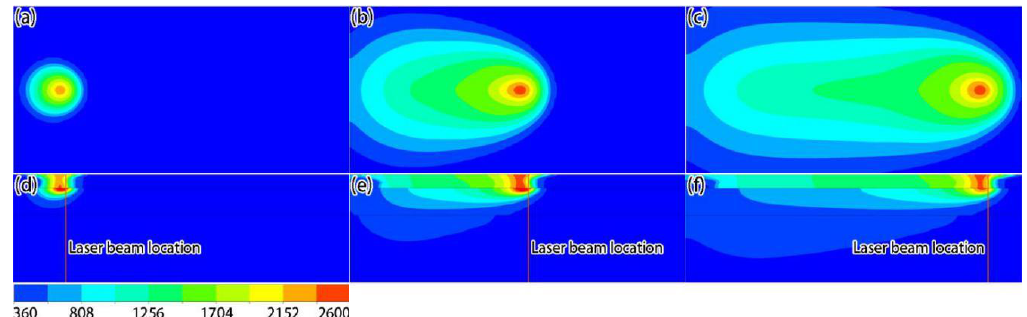
Figure 5. Simulation results of temperature fields in the top ( a – c ) and middle ( d – f ) sections at different times: ( a , d ) 6 × 10 −5 s; ( b , e ) 4.5 × 10 −4 s; ( c , f ) 8.4 × 10 −4 s (unit: K).